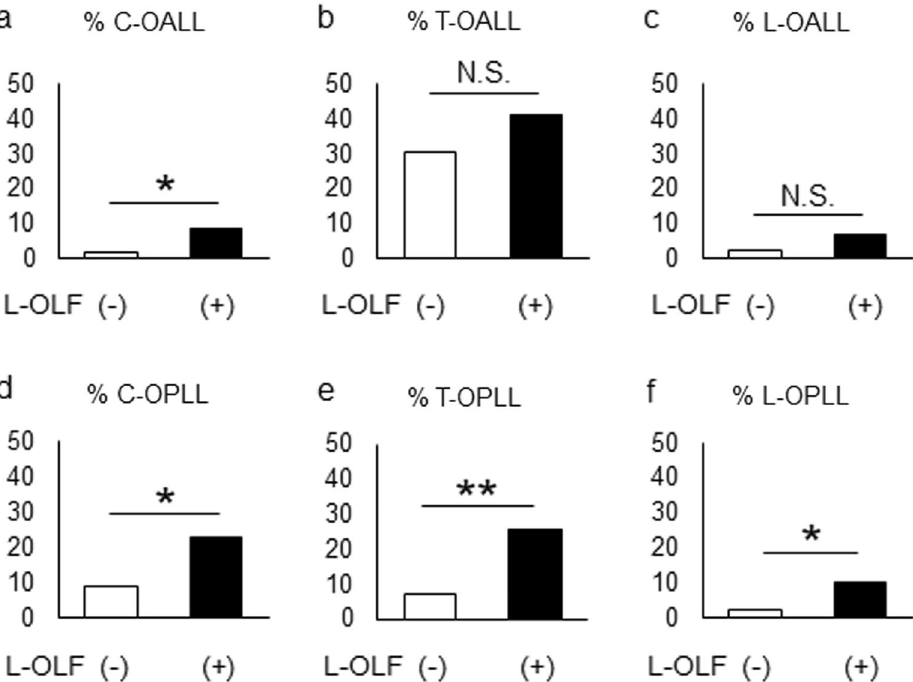
Figure 2. Comparison of comorbidity of OALL and OPLL in subjects with lumbar OLF [L-OLF(+)] or without lumbar OLF [L-OLF(−)]. * P < 0.01, ** P < 0.001, N.S. not significant. OALL ossification of the anterior longitudinal ligament, OPLL ossification of the posterior longitudinal ligament, OLF ossification of the ligamentum flavum, C cervical, T thoracic, L